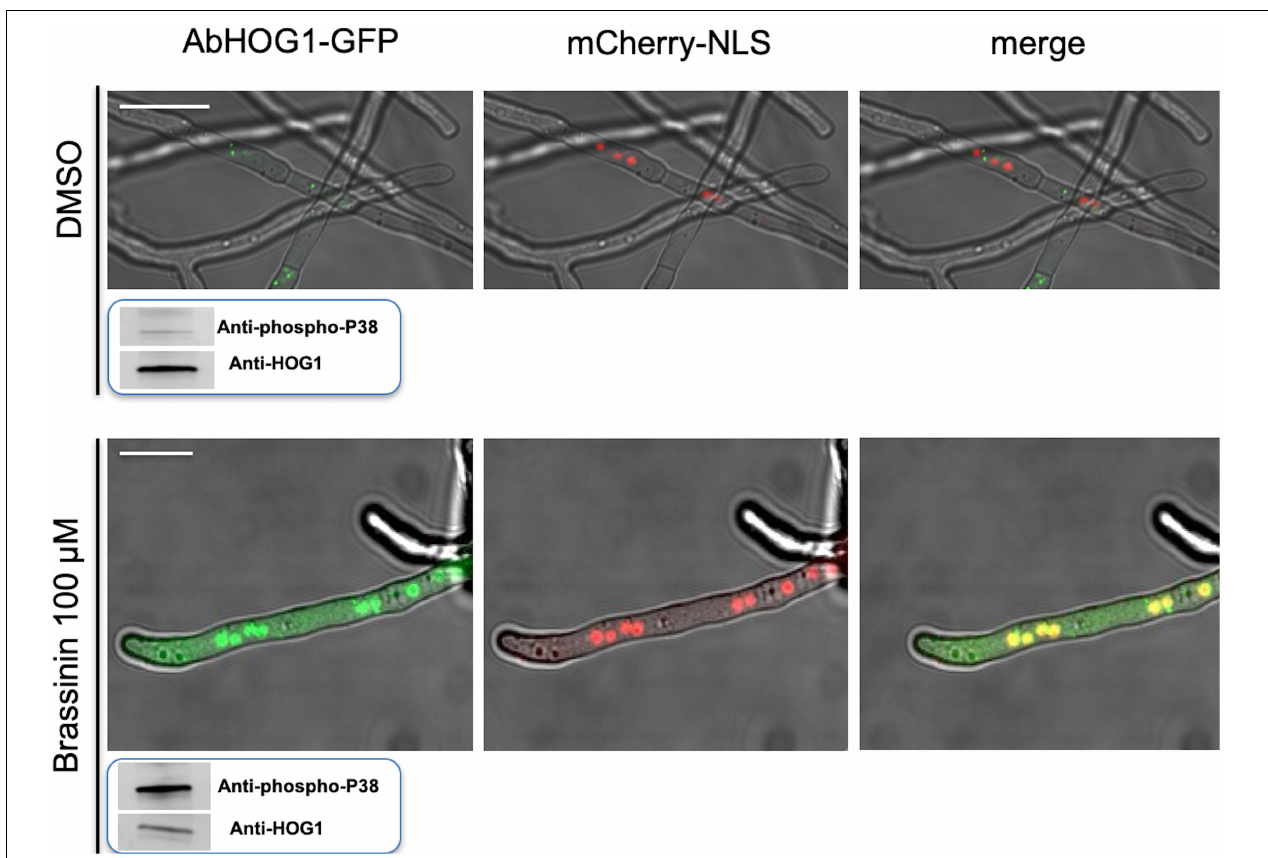
FIGURE 7 | Cellular localization of the AbHOG1-GFP fusion protein in hyphae exposed to either DMSO (control) or 100 µ M brassininin for 20 min and observed using confocal microscopy. Bars = 25 µ m. A double-labeled strain expressing AbHOG1-GFP and mCherry-NLS was used. In smaller panels located under the pictures is presented the phosphorylation of the HOG1-like MAPK in A. brassicicola wild-type after exposure to brassinin. Total protein extracts were blotted with either anti-Hog1 C -terminus antibody or anti-dually phosphorylated p38